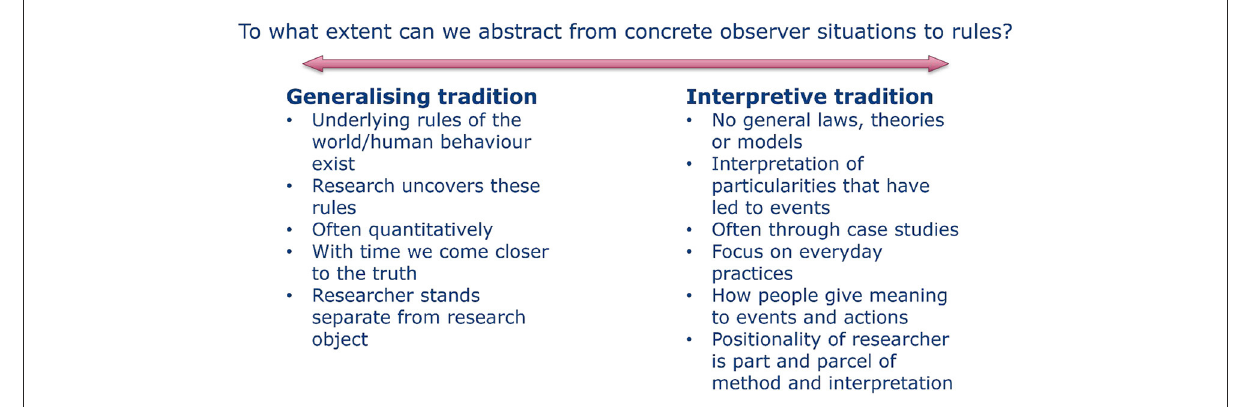
FIGURE1 Generalizing and interpretive traditions of science (own